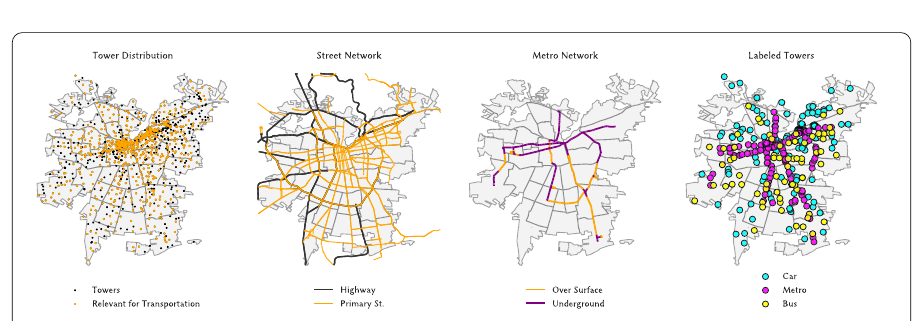
Figure 6 Maps of urban features analyzed in the algorithmic pipeline: the network of cell phone towers in the city, both under consideration and discarded ( e.g. , indoor towers); the street network, particularly highways and primary streets, from OpenStreetMap (OSM); the metro network, both, underground and over surface, also from OSM; and the set of labeled towers with respect to mode of transportation, according to their proximity to urban features and